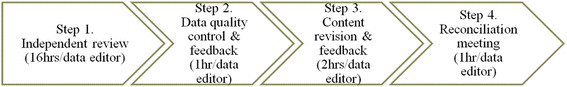
Workflow process for the individual data editors reviews.